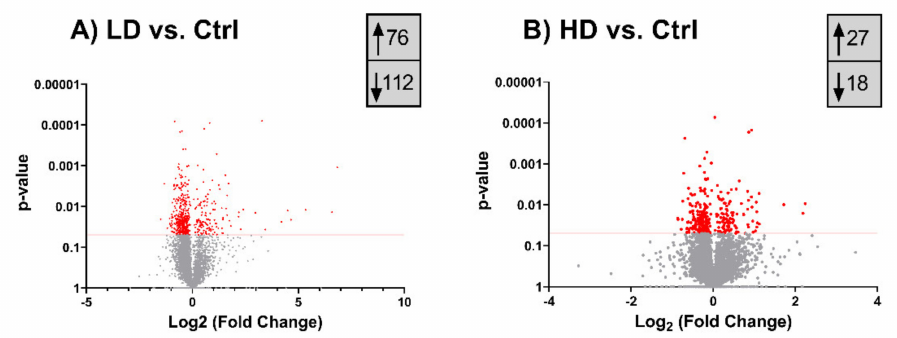
Figure 5. Differentially expressed proteins following 13 weeks TiO 2 exposure. ( A ) Differentially expressed proteins of LD relative to Ctrl. ( B ) Differentially expressed proteins of HD relative to Ctrl. The horizontal red lines indicate a p -value cut-off of 0.05 (proteins with p ≤ 0.05 indicated as red dots). The actual numbers of significantly up- and downregulated proteins are boxed in grey. Control (Ctrl), low dose (LD): 0.96 µ g/cm 2 and high dose (HD): 1.92 µ g/cm 2 .